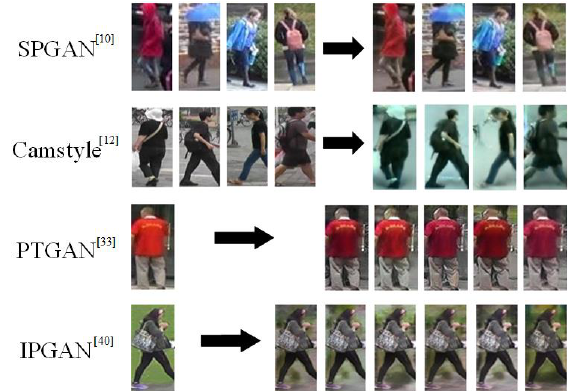
Figure 3. Transformed images obtained by different GAN-based person re-ID